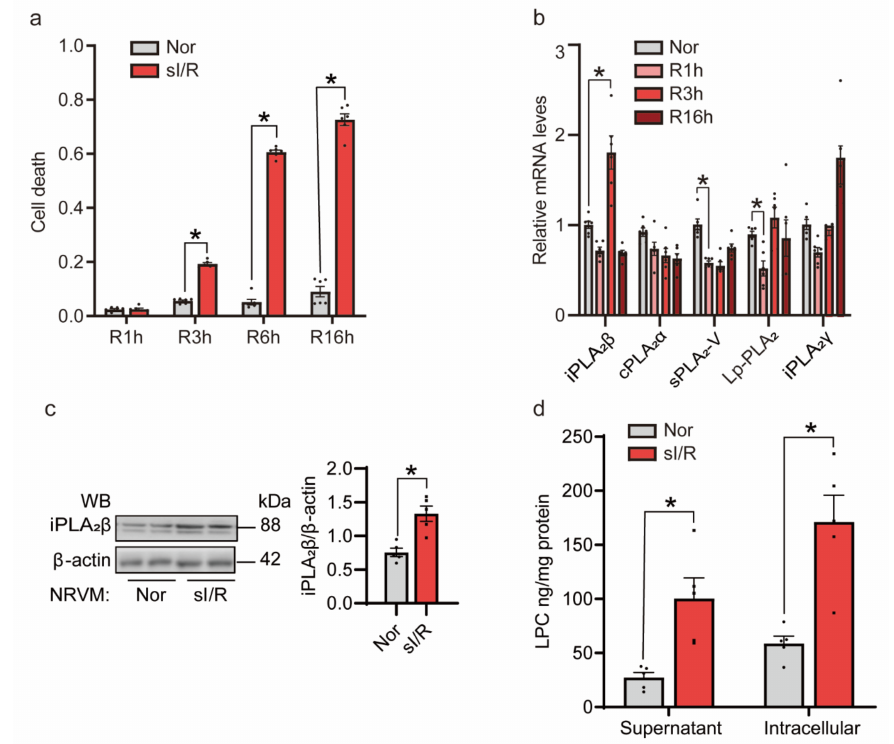
Figure 2. Simulated ischemia/reperfusion (sI/R) induces iPLA 2 β upregulation in neonatal rat ventricular myocytes (NRVMs). ( a ) sI/R caused significant cell death. NRVMs were subjected to 3 h of ischemia followed by 3, 6, 16 h of reperfusion. Lactate dehydrogenase (LDH) was determined in culture medium and in cell lysates, respectively. Relative cell death was calculated based on the ratio of released LDH in the medium. n = 6 per group. ( b ) sI/R led to strong induction of phospholipase A2 at the mRNA level. NRVMs were subjected to ischemia for 3 h, followed by different times of reperfusion. qRT-PCR was conducted to measure mRNA changes with 18S as an internal control. n = 6 per group. ( c ) sI/R induced the expression of iPLA 2 β at the protein level. Immunoblotting showed that iPLA 2 β was significantly increased at the protein level (left). β -actin was used as a loading control. Quantification is shown on the right. n = 5 per group. ( d ) Lysophosphatidylcholine (LPC) was increased during sI/R. NRVMs were subjected to 3 h of ischemia and 3 h of reperfusion. LPC ELISAs were performed to detect LPC concentrations in culture medium and in cell lysates. Relative LPC concentration in cell lysates was normalized based on total cellular protein concentrations. n = 5 per group. Data are represented as mean ± SEM. All experiments were independently replicated in triplicate. * p <